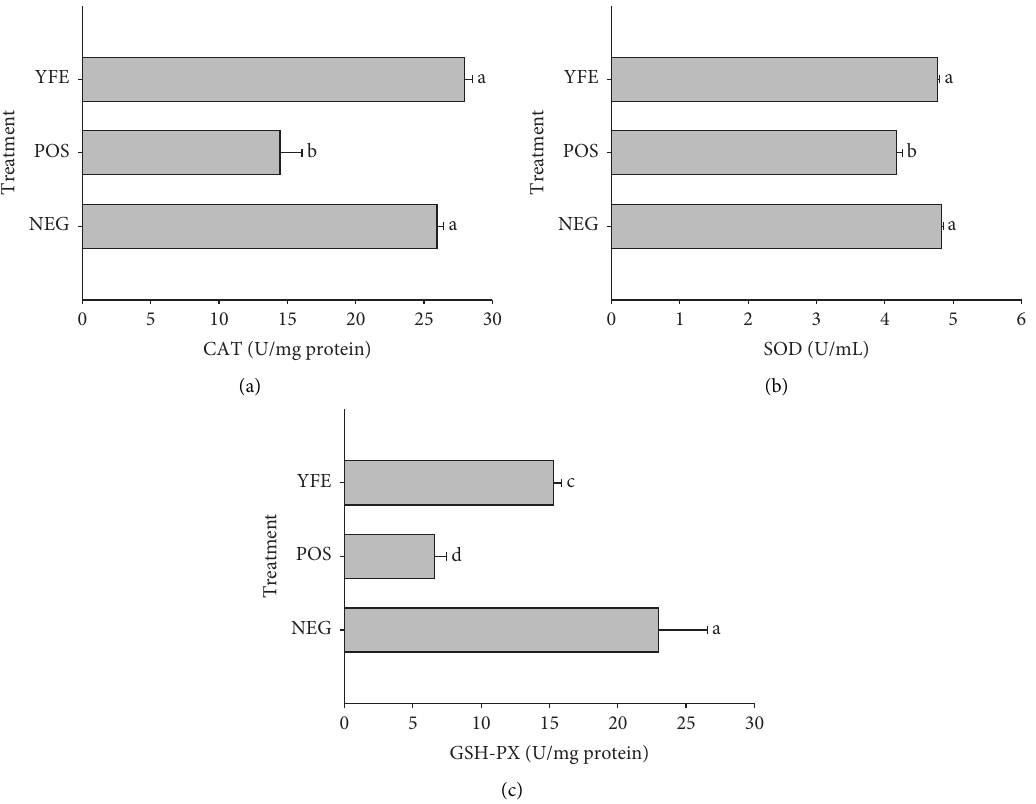
Figure 7: Effect of YFE pretreatment on the activities of antioxidant enzymes CAT (a), SOD (b), and GSH-PX (c) of Caco-2 cells under the oxidation stresses induced by H 2 O 2